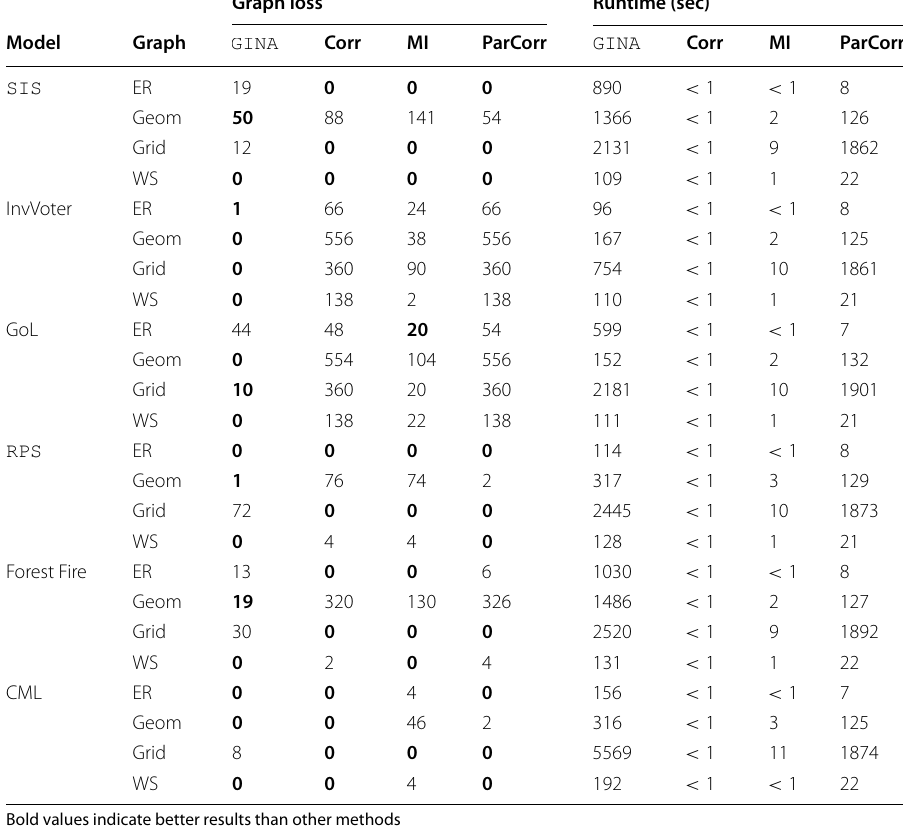
Bold values indicate better results than other methods